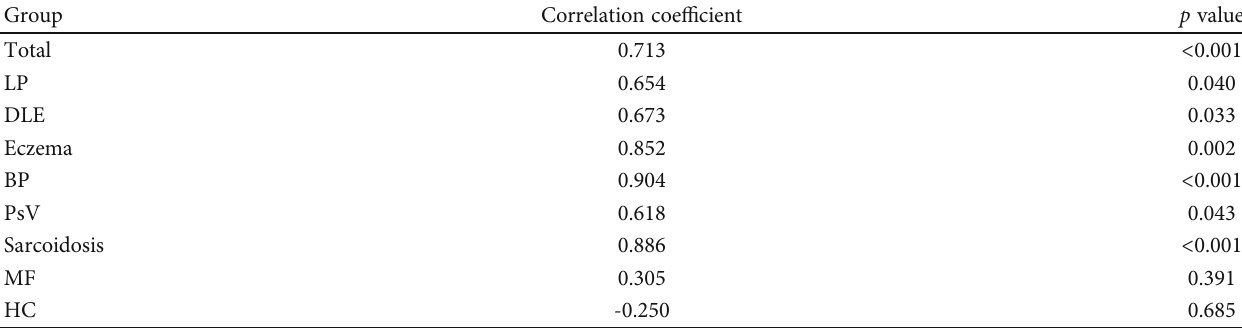
Table 4: Pearson ’ s correlation between stratum spinosum and stratum basale thymic stromal lymphopoietin expression.